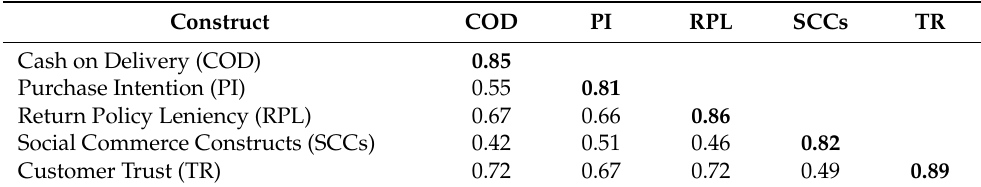
Table 3. Fornell and Larcker’s discriminant